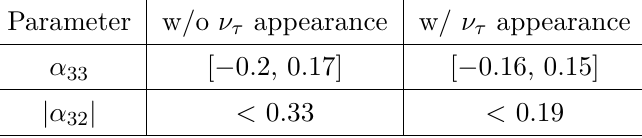
Table 10 . 90% C.L. limits on the NUNM parameters α 33 and | α 32 | from the DUNE setup. Second (third) column shows the results without (with) τ in the